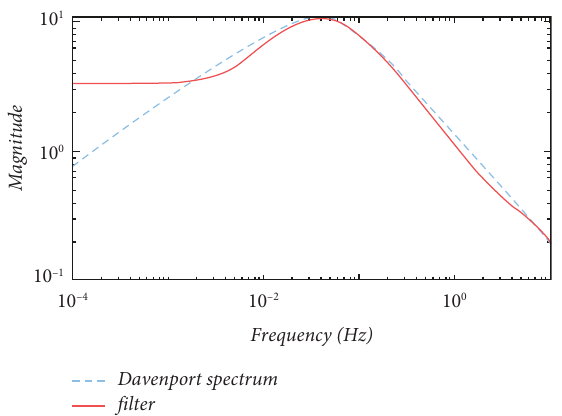
Figure 3: Te square root of the Davenport spectrum and mag- nitude-frequency curve of the flter.